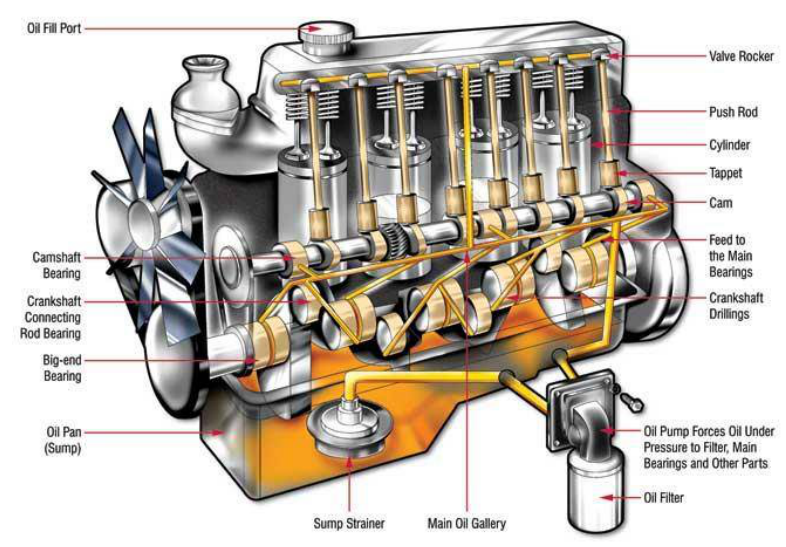
Figure 9. Inline four-cylinder engine [54].